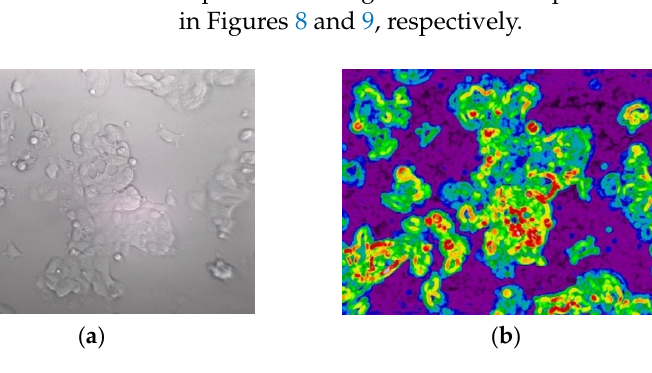
Figure 8. The segmentation of cells using gradient approach. ( a ) Grayscale image from Dataset_2_CONFL in apoptosis stage; ( b ) image applied morphological gradient; ( c ) binarization using a threshold value equal to 25.